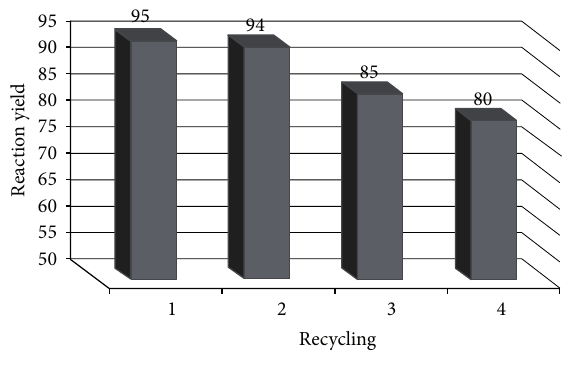
F 4: Reusability of Al/AT-silica for protection of benzyl